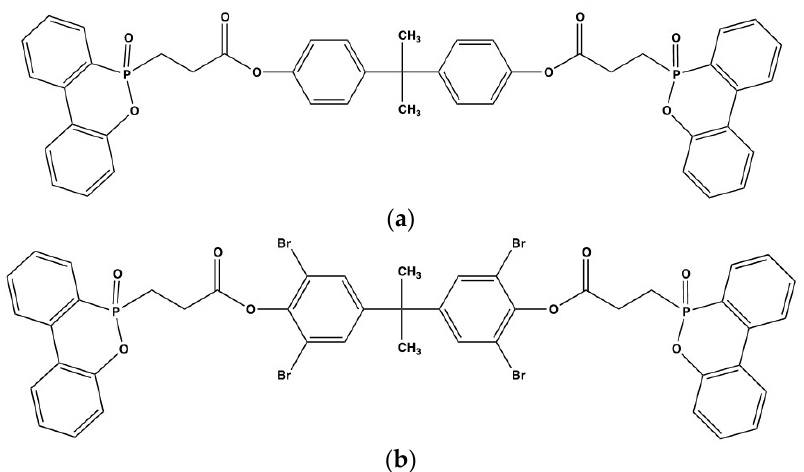
Figure 1. Structures for the DOPO adducts of bisphenol A and Tetrabromobisphenol A diacrylates. Structures for the DOPO adducts of bisphenol A and Tetrabromobisphenol A ( a ) 2,2-Di[4-(3-dopylpropanoyl)phenyl]propane (DDPP); ( b ) 2,2-Di[3,5-dibromo-4-(3- diacrylates. ( a ) 2,2-Di[4-(3-dopylpropanoyl)phenyl]propane (DDPP); ( b ) dopylpropanoyl)phenyl]propane (DBDPP). a In δ units respect the resonance of tetramethylsilane as internal reference. For comparison the corresponding DOPO derivatives of bisphenol A and tetrabromobisphenol A were prepared. Structures are shown in Figure 1.